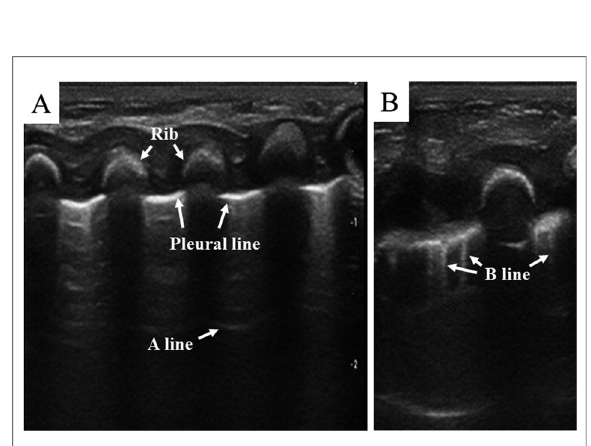
FIGURE 2 Normal lung pattern on lung ultrasonography. ( A ) Pleural line: the pleura is visualized as a smooth, regular echogenic line; A-lines: equidistant, horizontal, and echogenic lines distal to the pleural line. ( B ) B-line: vertical hyperechoic artifacts arising from the pleural